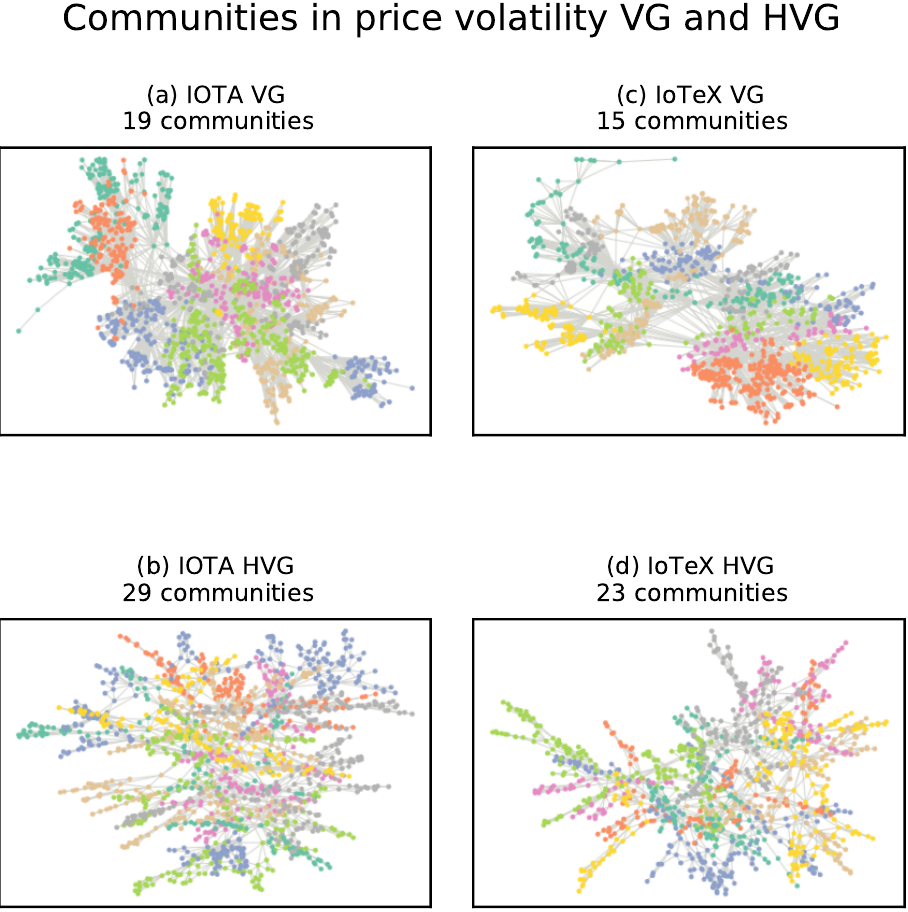
Figure 6. Communities identified by the networkx module community API in ( a ) IOTA VG, ( b ) IoTeX VG, ( c ) IOTA HVG and ( d ) IoTeX HVG throughout the timeline in network graph